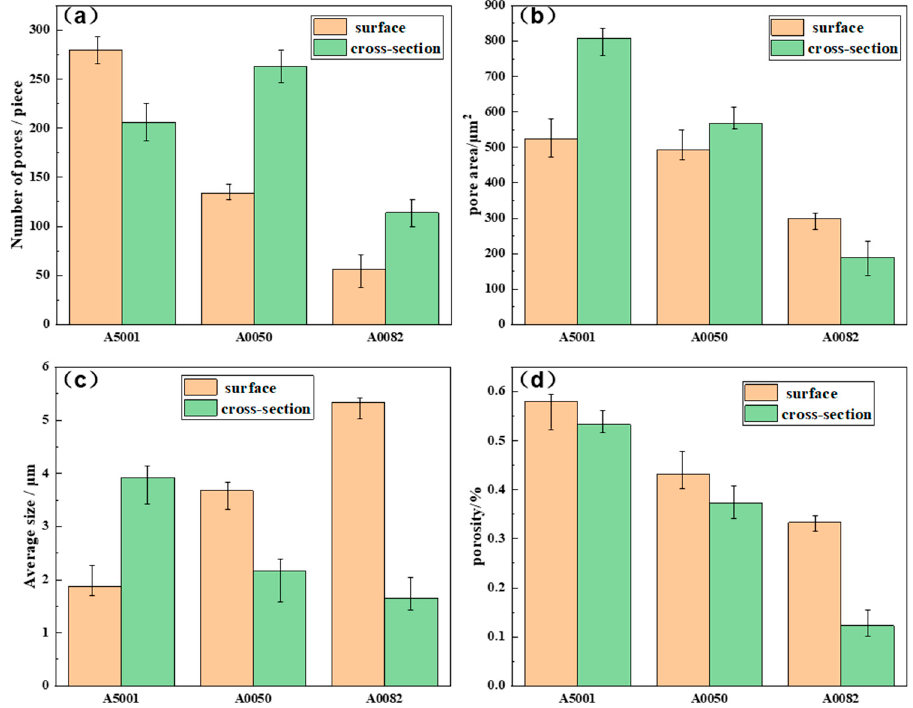
Figure 3. Surface porosity of coatings prepared by different powders: ( a ) number of pores; ( b ) pore area; ( c ) average pore size; ( d ) porosity.